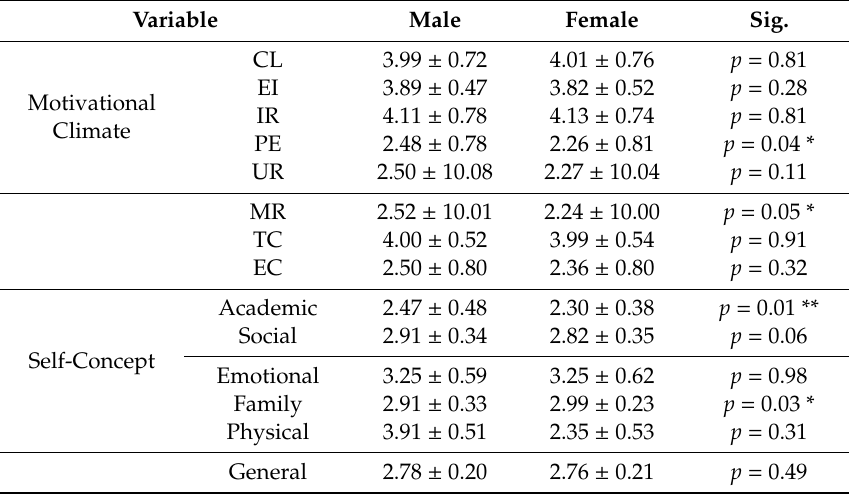
Table 1. Motivational climate and self-concept levels according to gender.